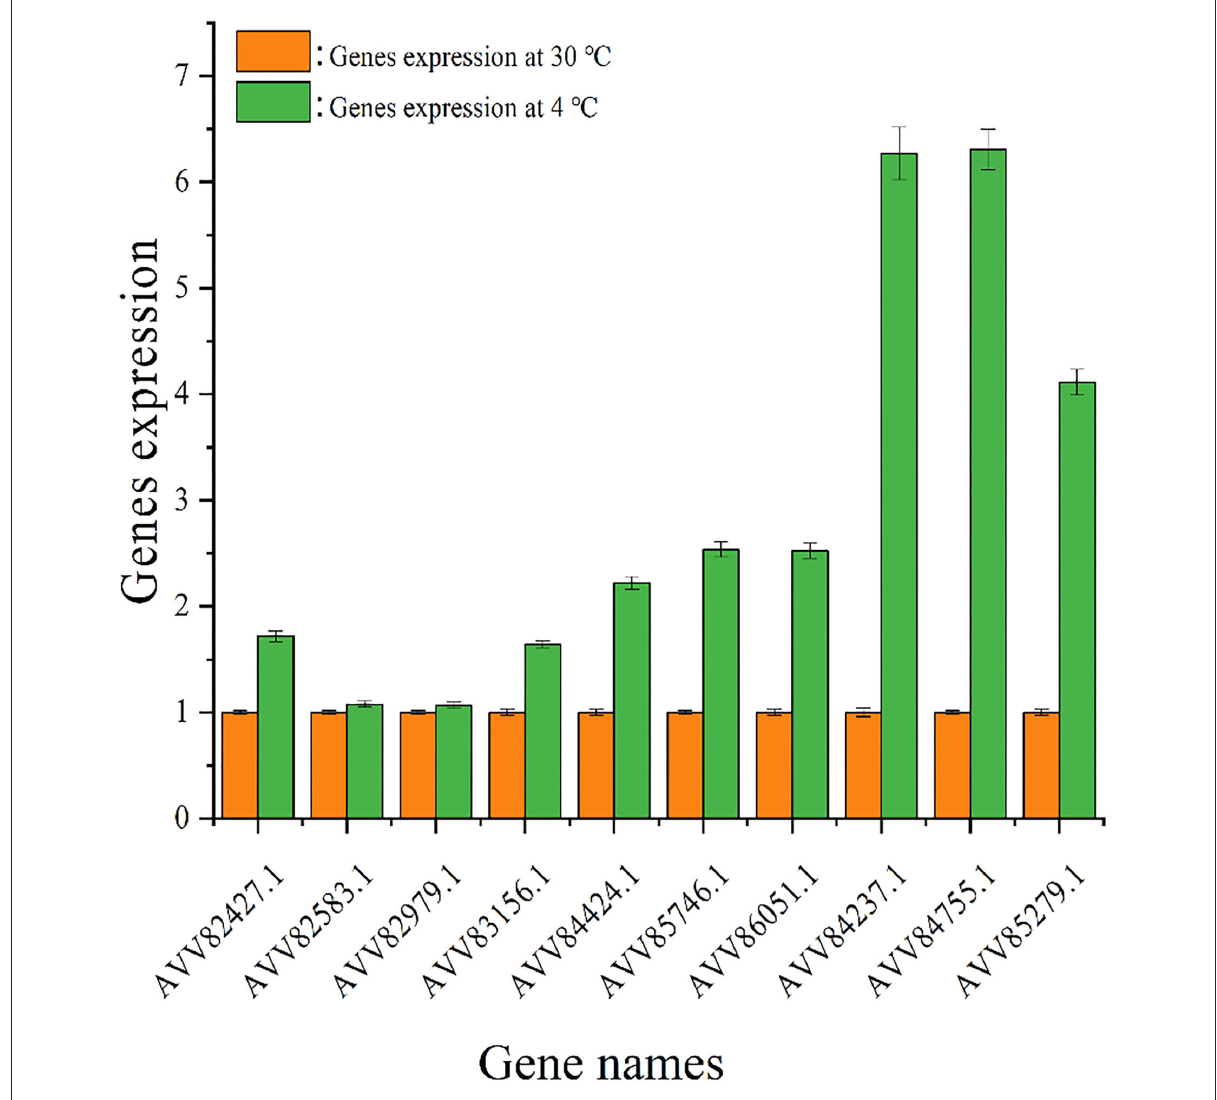
FIGURE6 Expression of genes encoding diguanylate cyclases. The expression of genes encoding diguanylate cyclases under 30 ( ) and 4 ◦ C (